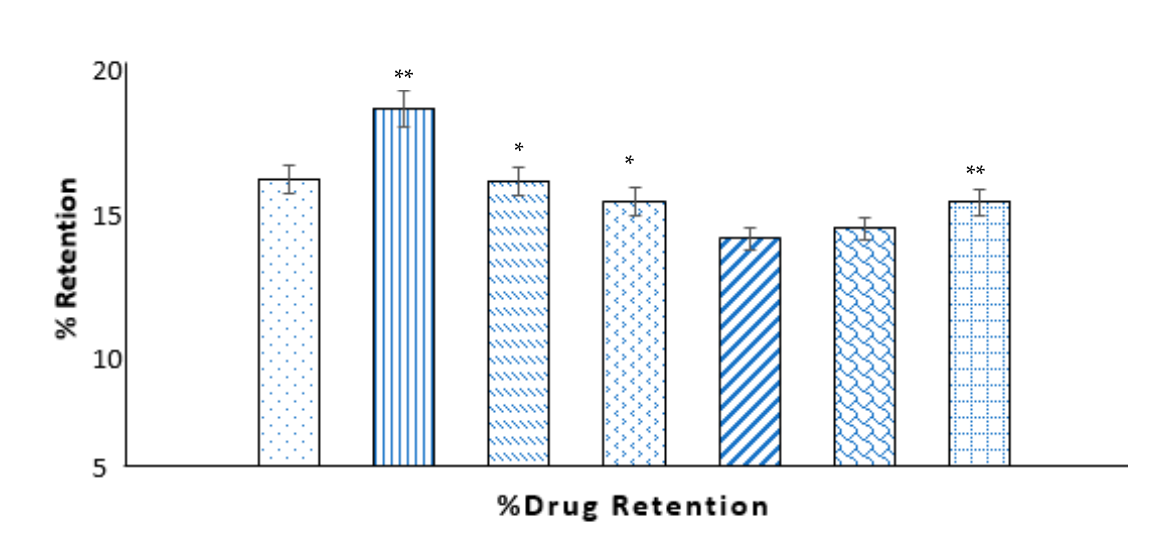
Figure 5. % Drug retention of different formulations: n = 3, mean ± S.D., * p < 0.05 and ** p < 0.001 considered statistically significantly different from VRZNA, VRZNE, and VRZNF.